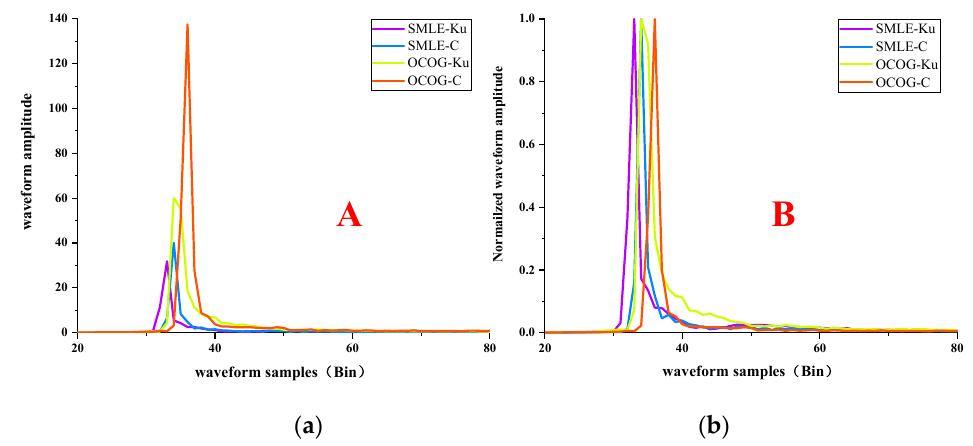
Figure 5. Original and normalized waveforms of the SMLE and OCOG of the quasi-specular surfaces. Figure 5. Waveforms of the SMLE and OCOG from the quasi-specular surfaces: ( a ) original waveforms of the two di ff erent tracking packets; ( b ) the normalized waveform of the two di ff erent tracking